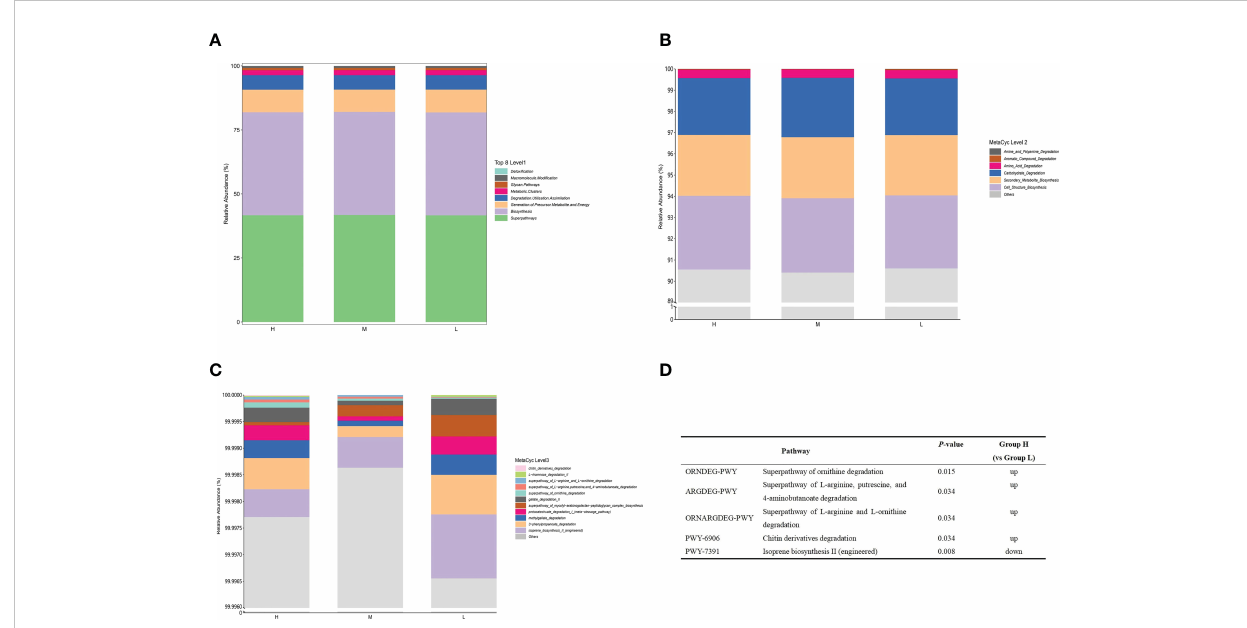
FIGURE 8 Functional pro fi les of salivary microbiome among different CA groups. The comparison of functional pathways at the MetaCyc level 1 (A) , level 2 (B) , and level 3 (C) . (D) The signi fi cantly altered functional pathways between the H and L